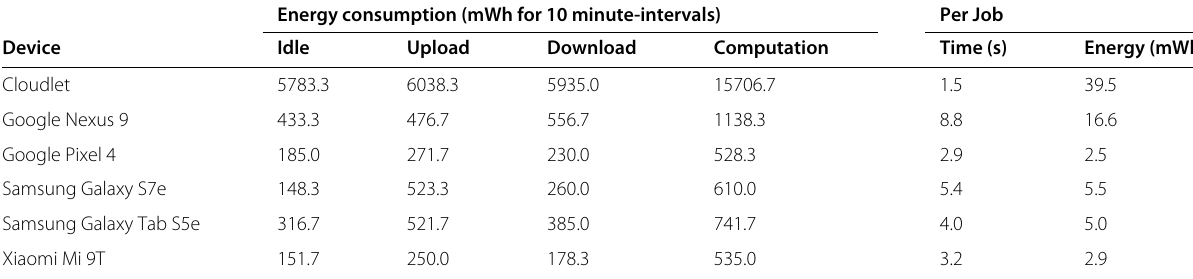
Table 4 Baseline results per